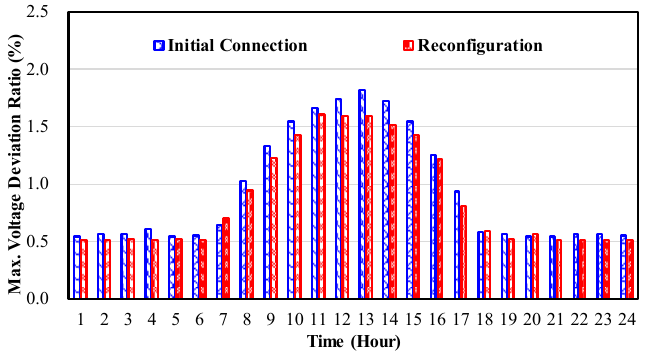
Figure 10. Daily voltage deviation ratio of initial connection and reconfiguration in the test feeder.